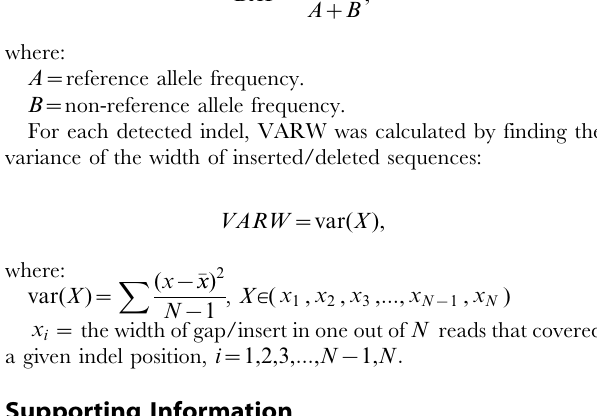
Figure S1 A potential novel insertion detected in DH10B. The top, middle and bottom are IGV pileups at a selected region generated by data from MiSeq, filtered PGM TM , and SOLiD 4 respectively. The selected region showed a potential novel insertion that was not found in the DH10B genome (highlighted by dotted lines). The insertion was not detected in SOLiD4 possibly because the position of the insertion was mainly covered at the end of reads. Figure S2 Homopolymer run lengths of indels filtered and unfiltered by VARW threshold in DH10B. Panels (A) and (B) are barplots showing the proportions of indels with different homopolymer run lengths in filtered and unfiltered data derived from the E.coli DH10B strain respectively. BAF th was set to zero so that only the effect of VARW was evaluated. (A) More than 74% of the filtered indels were found to be associated with